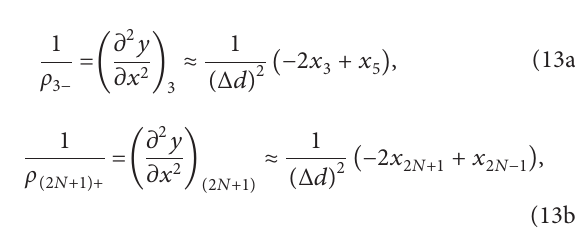
Figure 6: The equivalent balance between the shear force with the stiffness